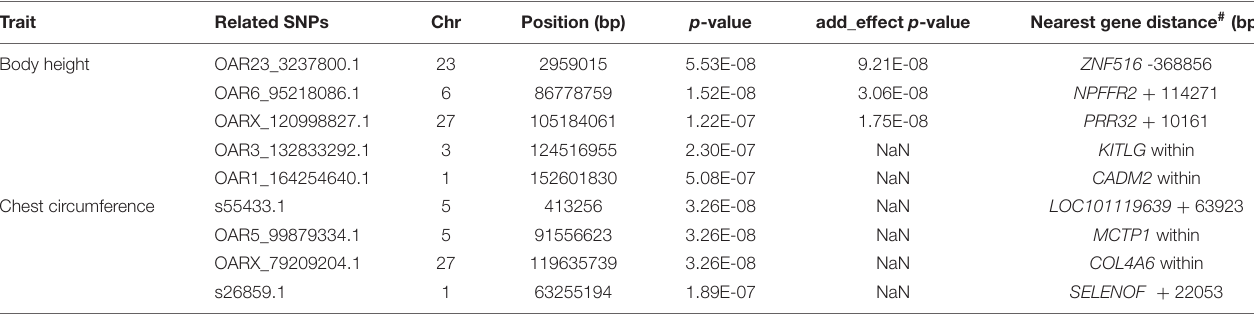
FIGURE 3 | Manhattan plot of analysis results; -log 10 ( p -values) in the studied population of Hu sheep. (A) Manhattan plot of the results of the body height analysis. (B) Manhattan plot of the results of the chest circumference. TABLE 1 | Analysis of related SNPs associated with body size traits of Hu